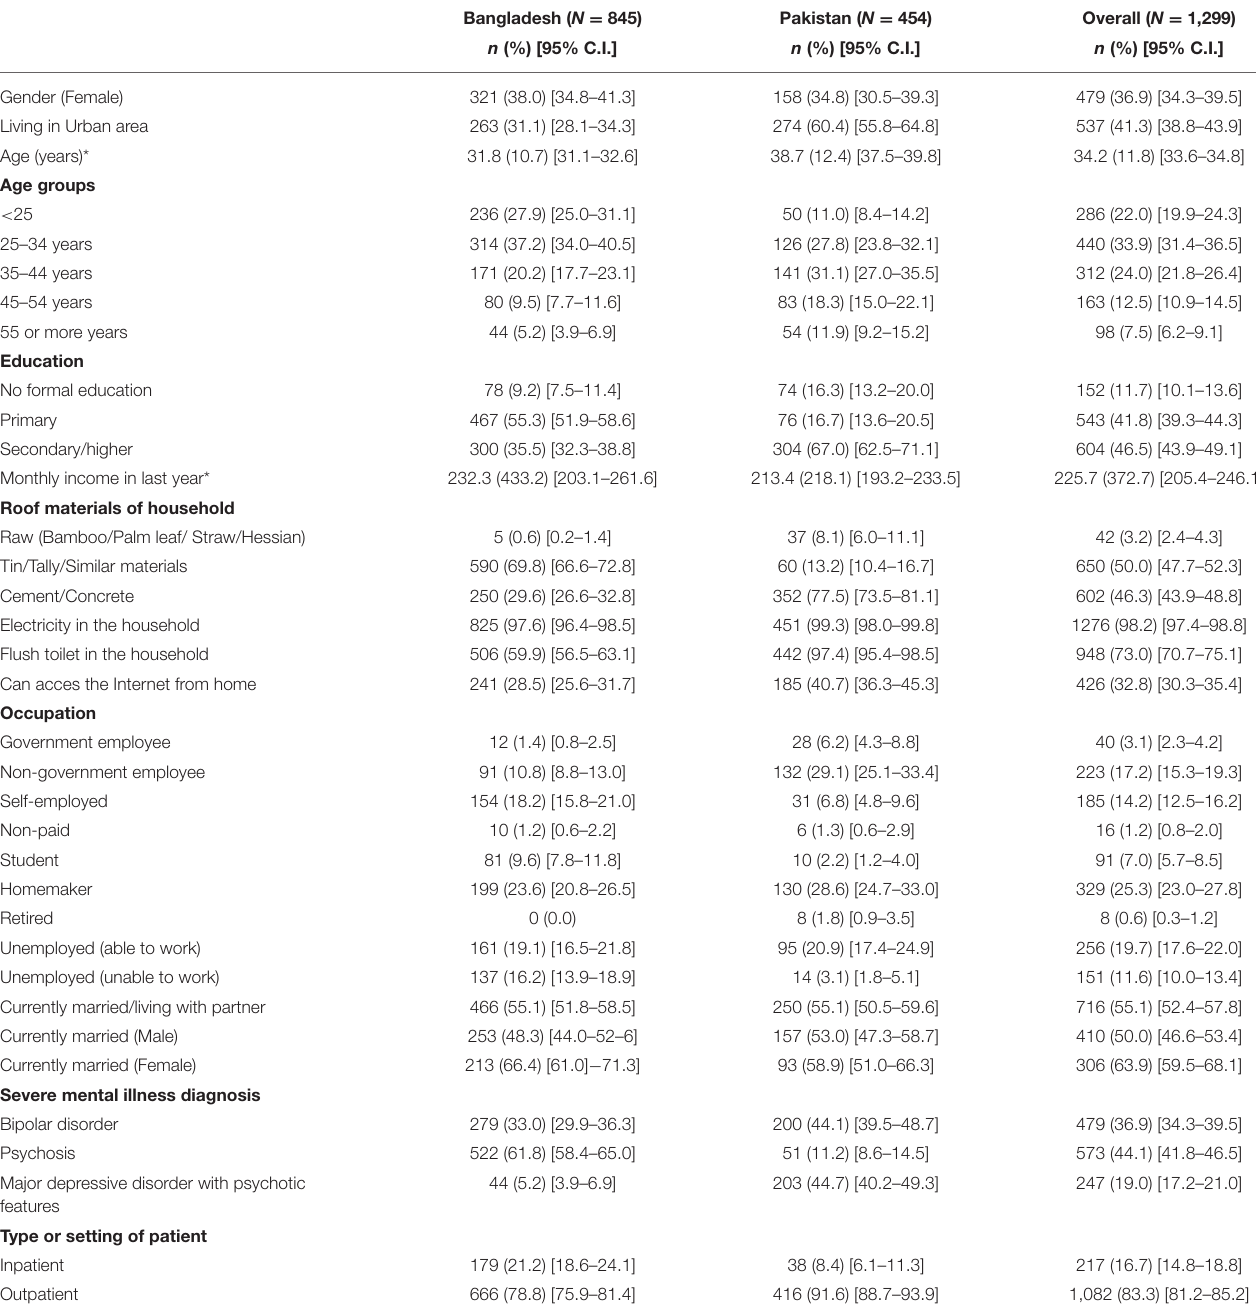
TABLE 1 | General characteristics of the sample at